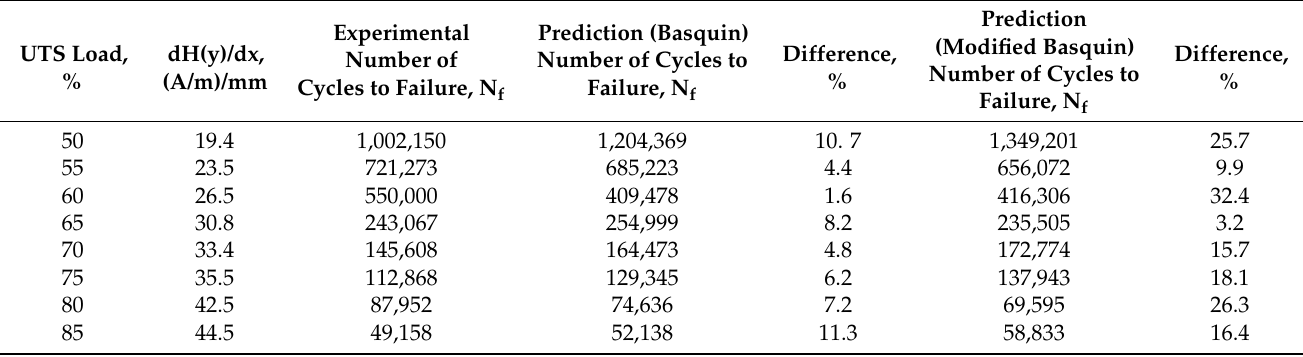
Table 5. Fatigue lives of API steel grade